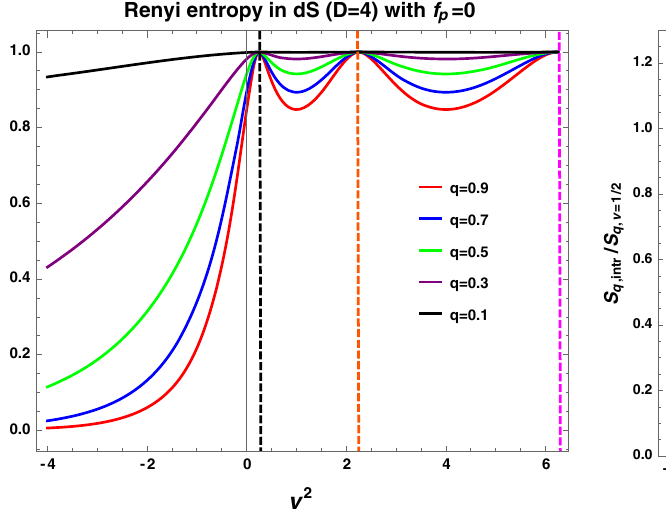
( a ) Normalized R´ e nyi entropy vs ν 2 in 3+1 D de Sitter space without axionic source ( f p = 0). Fig. 9 Normalised Rényi entropy S intr / S ν = 1 / 2 vs. mass parameter ν 2 in 3 + 1 D de Sitter space in the absence of the axionic source ( f p = 0) and in the presence of the axionic source ( f p = 10 − 7 ) for q = 0 . 1 ( black ), q = 0 . 3 ( purple ), q = 0 . 5 ( green ), q = 0 . 7 ( blue ), q = 0 . 9